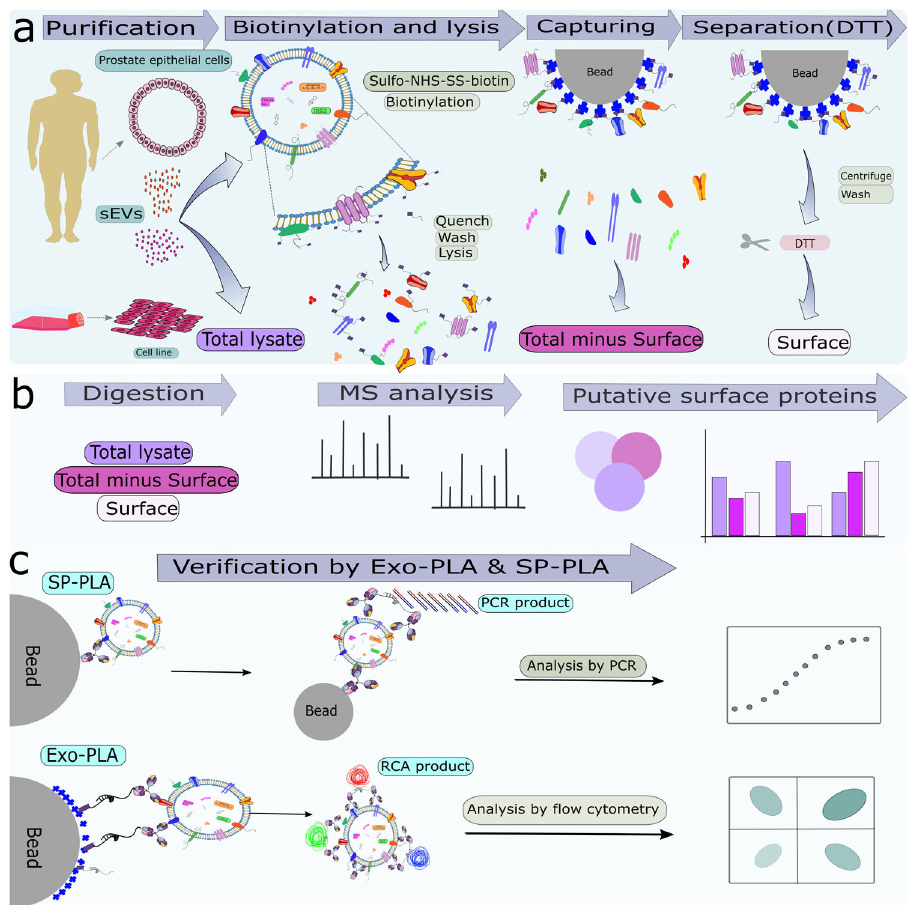
Fig. 1 Schematic illustration of the strategy to identify and validate sEV surface proteins. a SEVswere isolated from human seminal fl uidsand PC3 culture media, respectively, and were treated with sulfo-NHS-SS-biotin to biotinylate outer membrane proteins on the surface of the sEVs before addition of lysis buffer. Biotinylated surface proteins were captured on streptavidin beads, and were released by DTT. b Total, total minus surface, and surface proteins were digested and identi fi ed by label-free semi-quantitative HRMS analysis. c The presence of these proteins was validated by Exo-PLA and